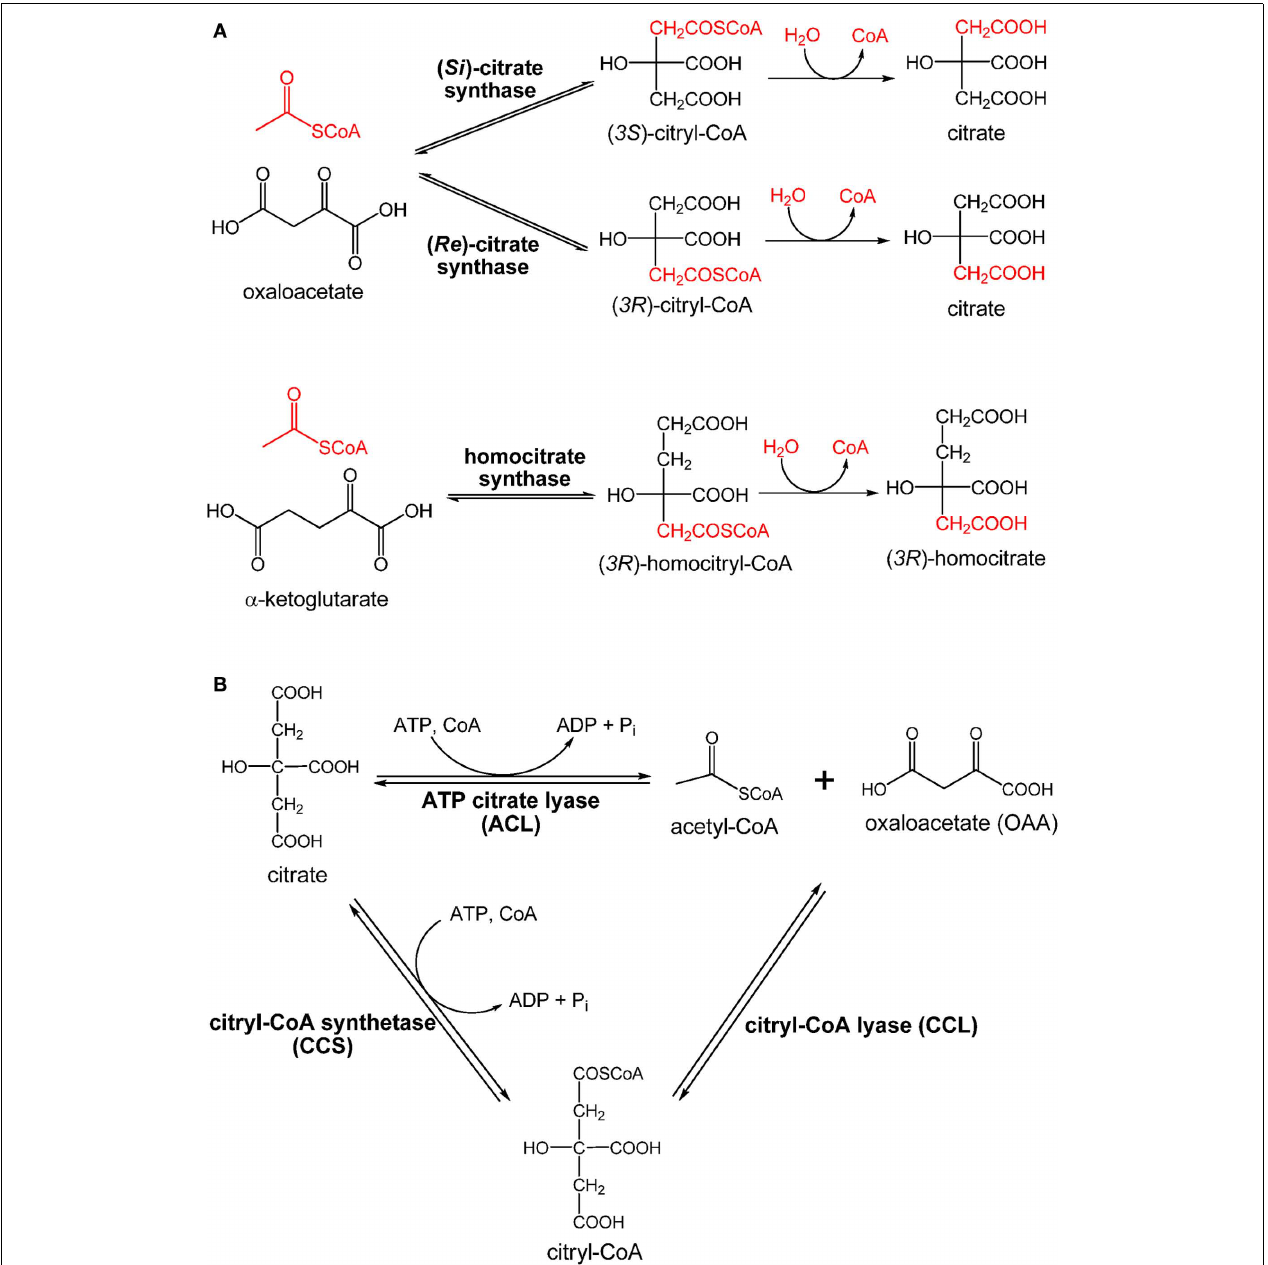
FIGURE 6 | Enzymes involved in citrate metabolism and central carbon metabolism. Claisen condensation catalyzed by ( Re )-citrate synthase, ( Si )-citrate synthase, and homocitrate synthase (A) and retro-aldol reactions catalyzed by ATP citrate lyase (ACL) and citryl-CoA synthetase (CCS)/citryl-CoA lyase (CCL) (B) are